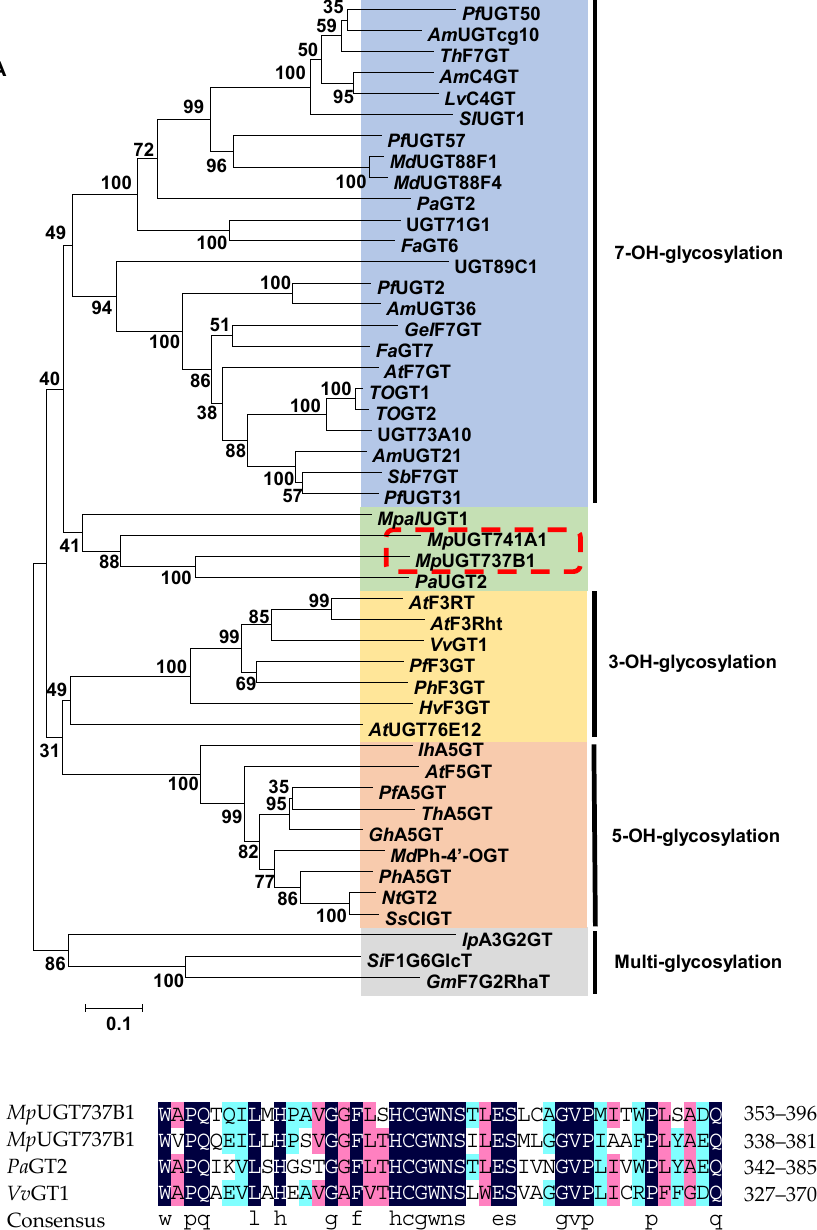
Figure 1. Phylogenetic analysis and sequence alignment of M. polymorpha UGTs. ( A ) Phylogenetic tree of Mp UGTs. The sequences were aligned using the ClustalW algorithm, based on the neighbor-joining method. ( B ) PSPG boxes of Mp UGTs, Pa GT2 and Vv GT1.